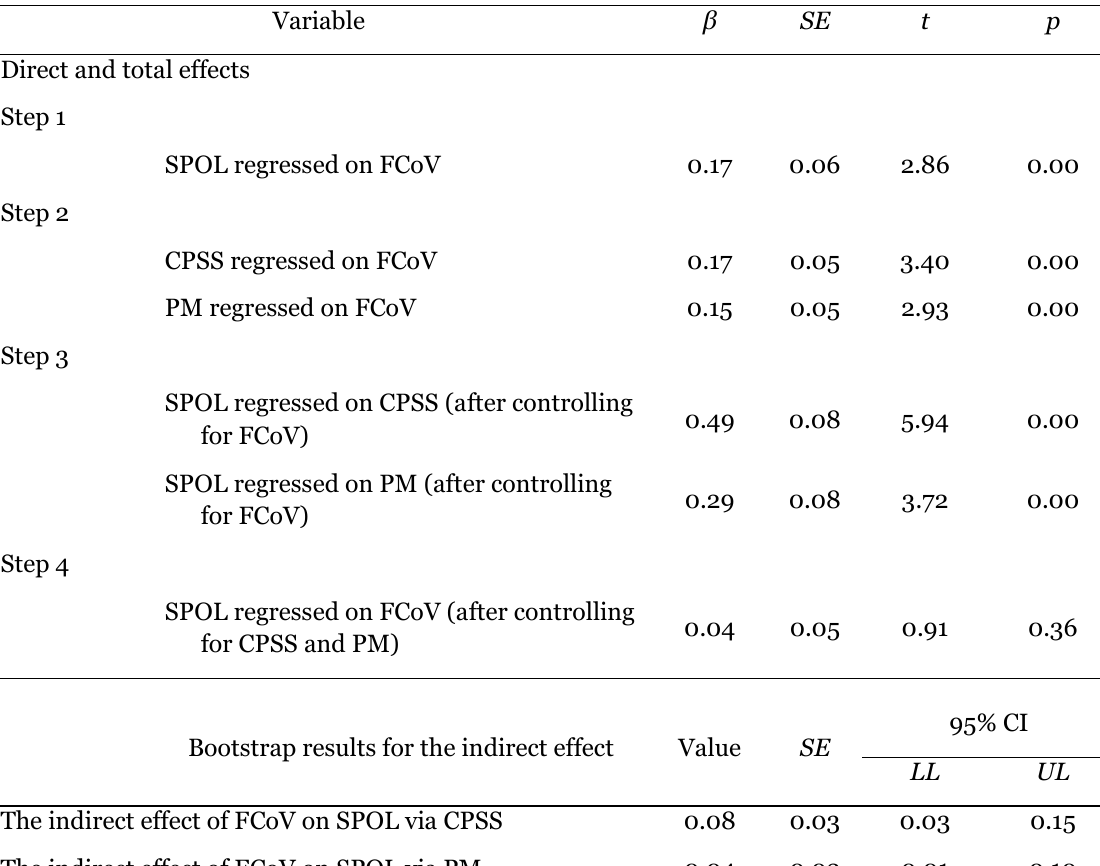
Table 9 Regression Results for Parallel Mediation in Pakistan Variable